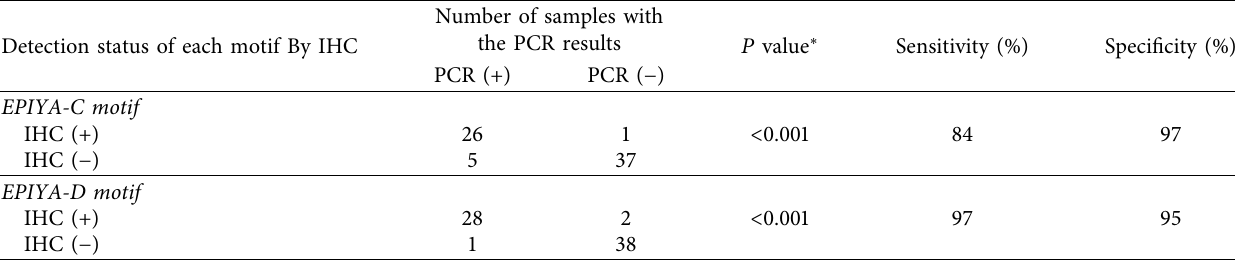
Table 3: Detection sensitivity and specifcity of IHC for an EPIYA-C or EPIYA-D motif of H. pylori in gastric biopsy samples compared with the PCR